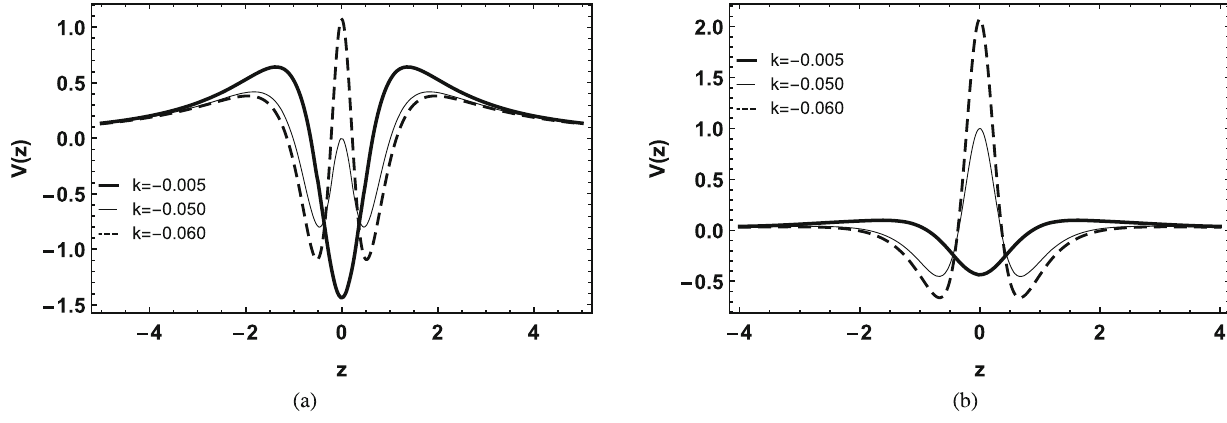
Fig. 11 Effective potential behavior for G 1 ( T ) with n = 2 and p = λ = 1. a Gauge field. b KR